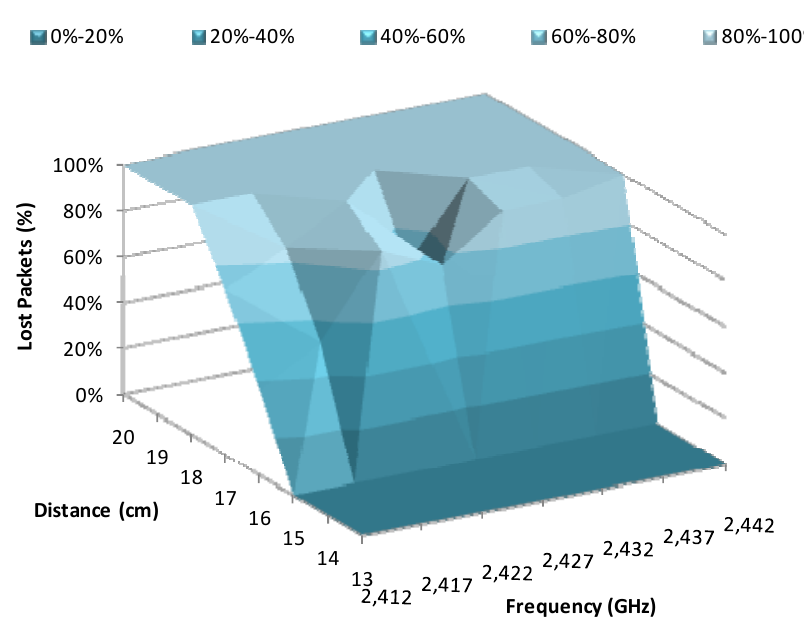
Figure 13. Lost packets for 11